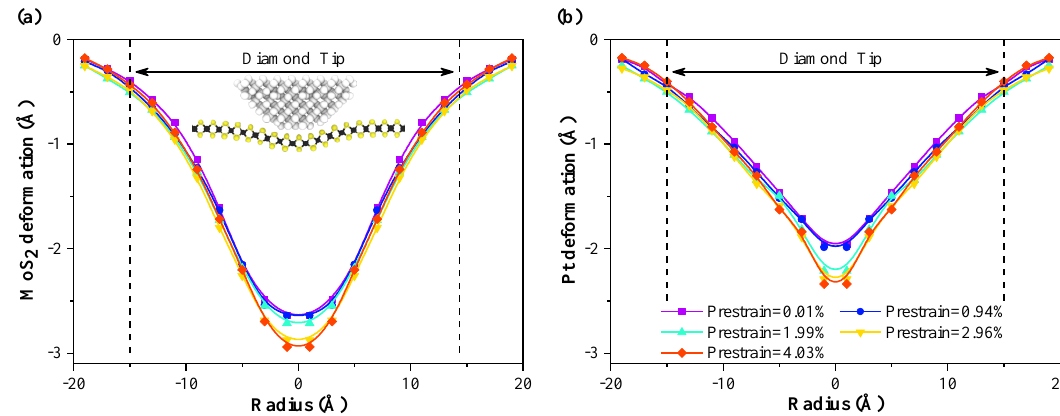
Figure 4. Radially averaged deformation distribution of monolayer MoS 2 ( a ) and Pt substrate ( b ) at the end of the elastic stage, obtained by averaging the atomic displacement from the center of the contact area at radial intervals of 2.0 Å. To better reflect the deformation of the Pt substrate, only the top three layers of Pt atoms are considered.